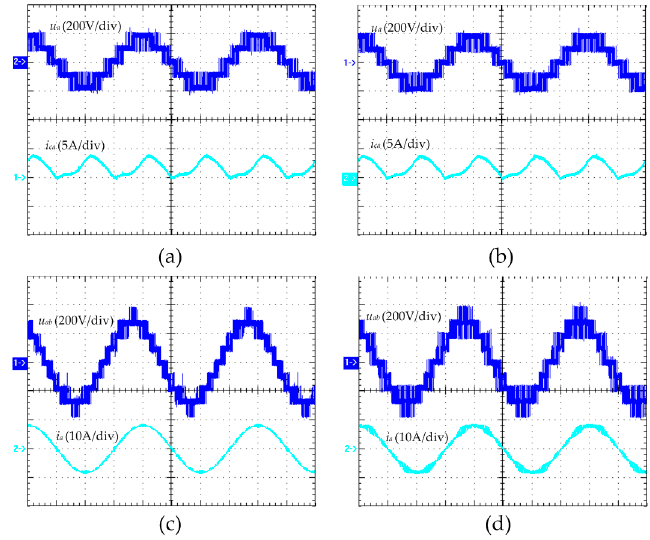
Figure 11. Experimental waveforms of DCPDPWM method and PSCPWM method with circulating current harmonics cancellation scheme: ( a ) phase voltage and circulating current of DCPDPWM; ( b ) phase voltage and circulating current of PSCPWM; ( c ) line-to-line voltage and phase current